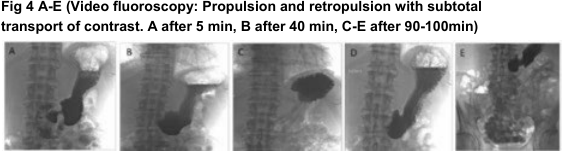
Fig 4 A-E (Video fluoroscopy: Propulsion and retropulsion with subtotal transport of contrast. A after 5 min, B after 40 min, C-E after 90-100min)